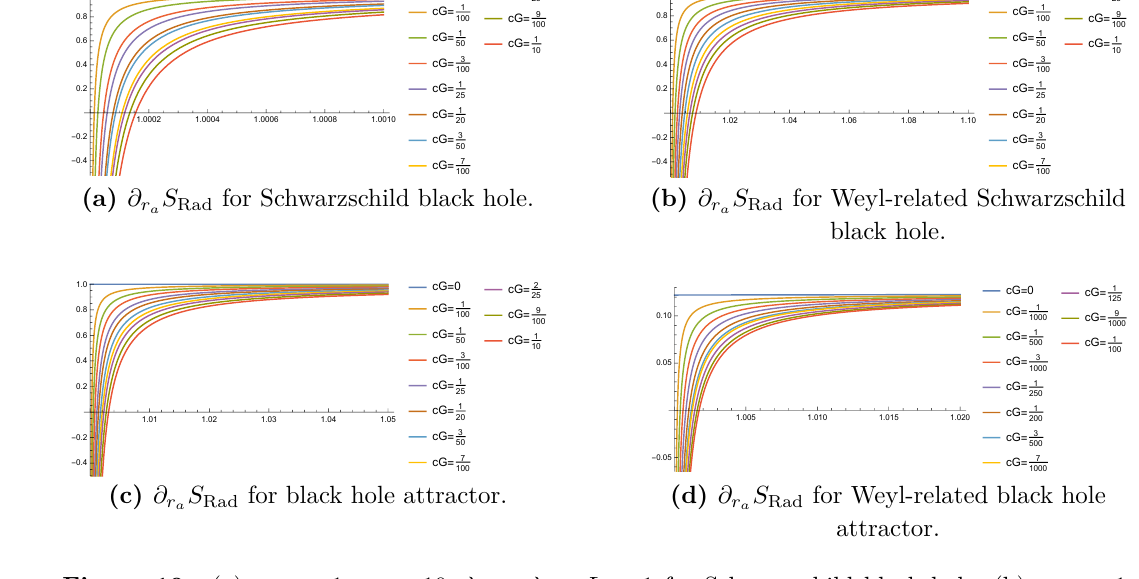
Figure 10. (a). r h = 1 , r b = 10 , λ p = λ = L = 1 for Schwarzschild black hole, (b). r h = 1 , r b = 10 , λ p = λ = L = 1 for Weyl-related Schwarzschild black hole, (c). r h = 1 , r b = 10 , λ p = λ = L = 1 for black hole attractor, (d). r h = 1 , r b = 10 , λ p = L = 1 and λ = 0 . 1 for Weyl-related black hole